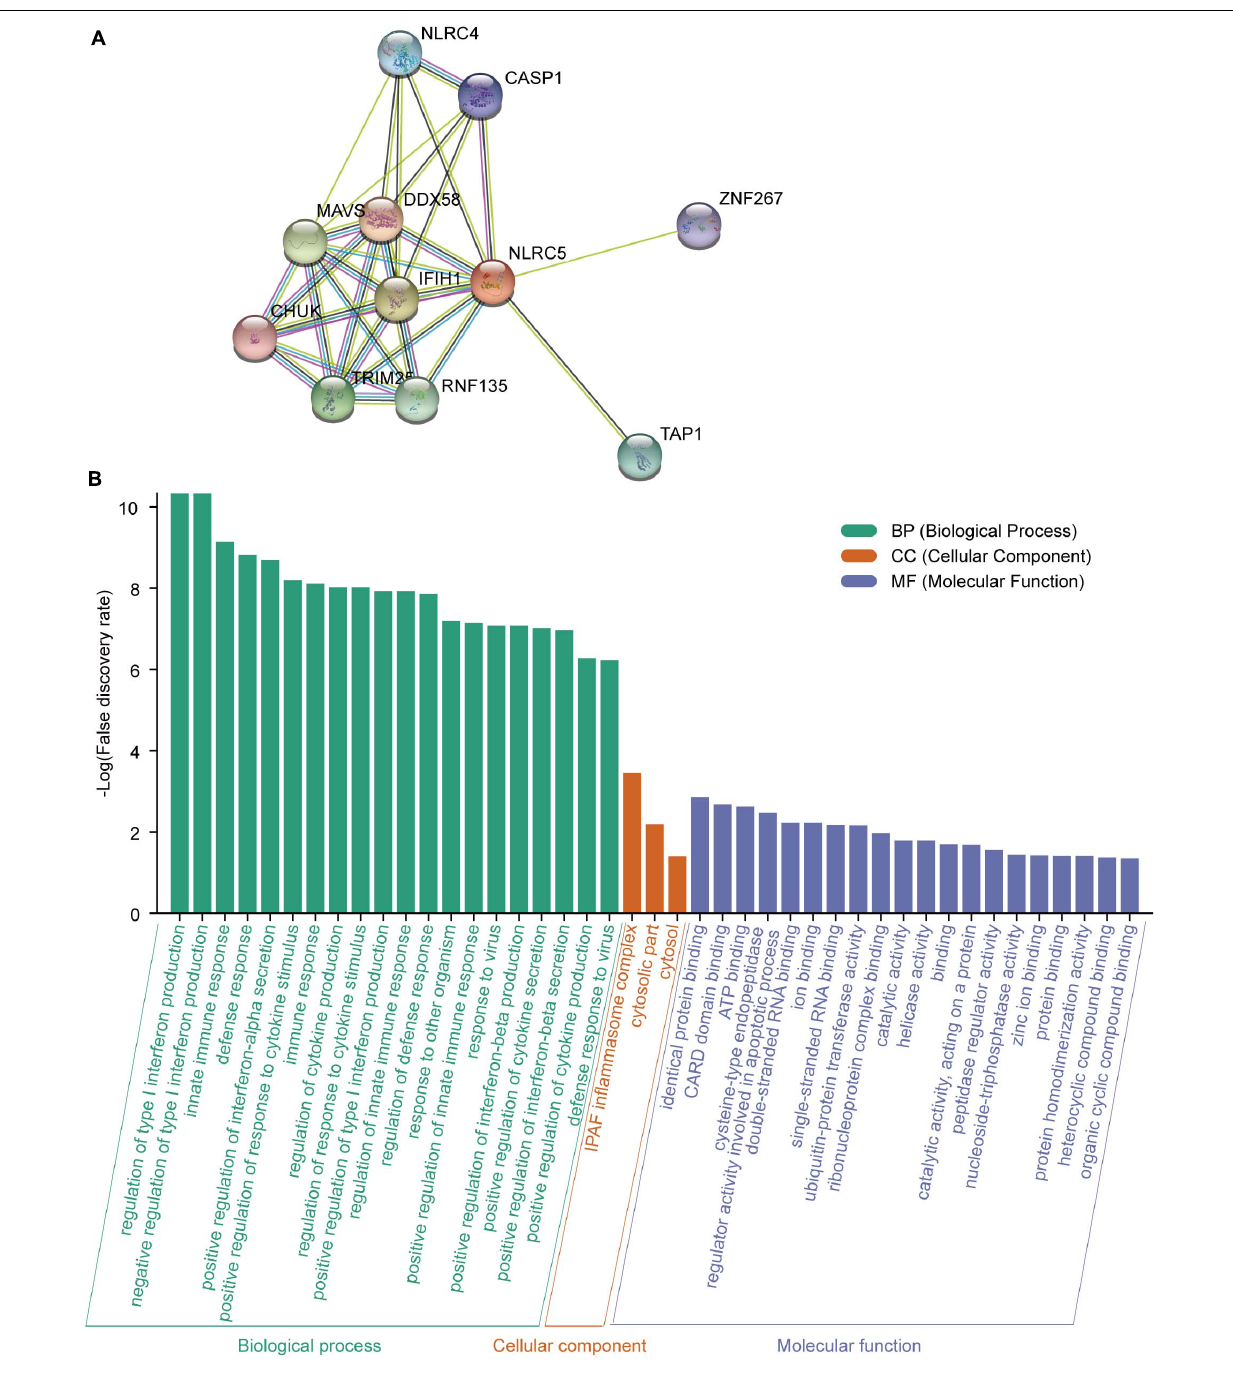
FIGURE 8 | Analysis of the NLRC5 interacting proteins using STRING. (A) Protein-protein interaction (PPI) network of NLRC5 visualized by STRING. (B) Functional enrichment analysis of NLRC5 interacting proteins in three modules: GO (Biological Process), GO (Molecular Function), and GO (Cellular